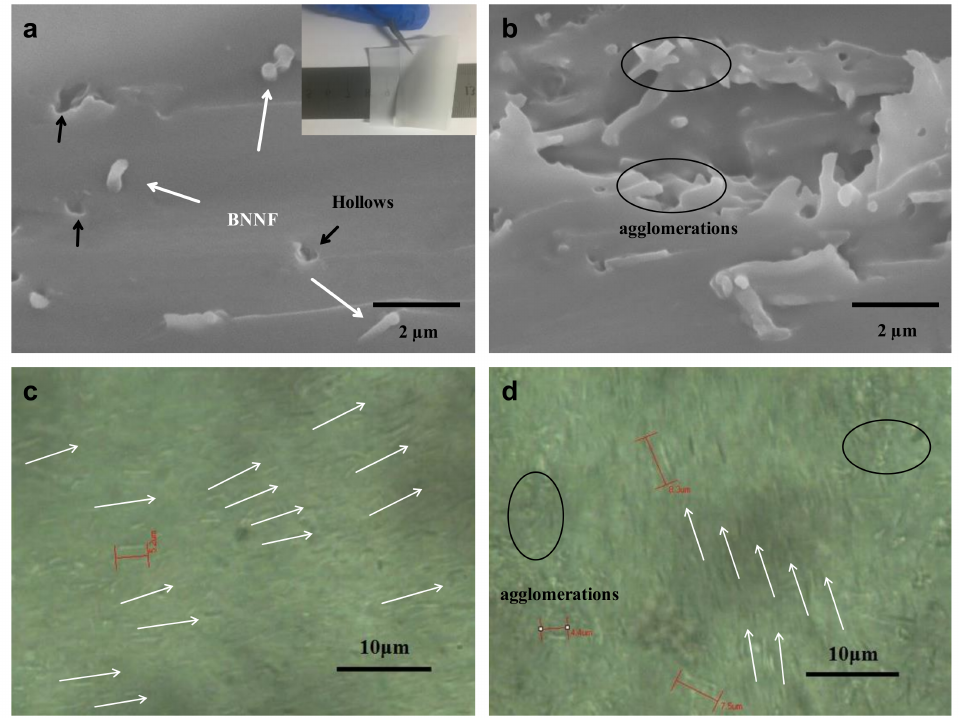
Figure 3. SEM cross-section image of ( a ) 1 wt% BNNF/EP and ( b ) 2 wt% BNNF/EP film. The inset in ( a ) shows the flexibility and transparency of sample. Optical microscope surface photograph of ( c ) 1 wt% BNNF/EP and ( d ) 2 wt% BNNF/EP composite